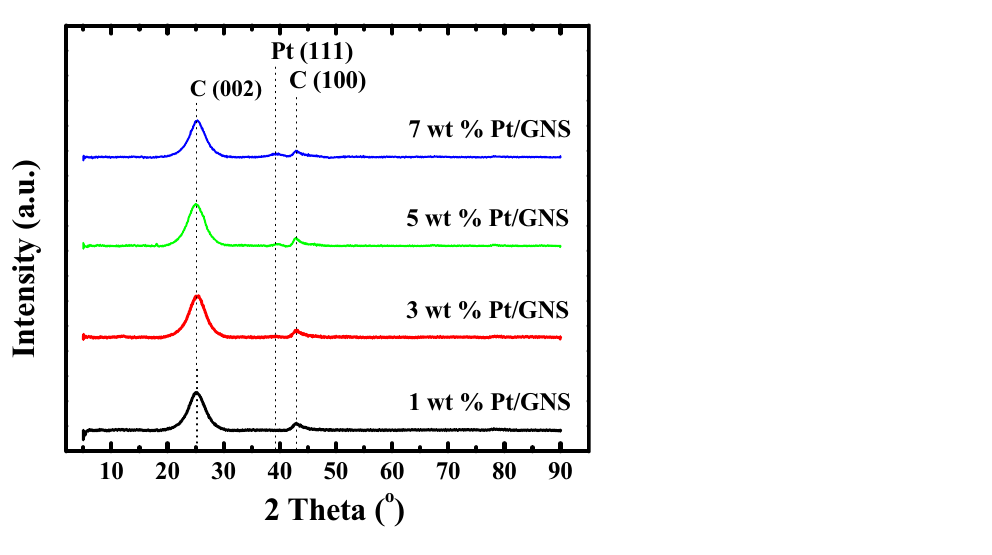
Figure 3. XRD patterns of 1–7 wt.%